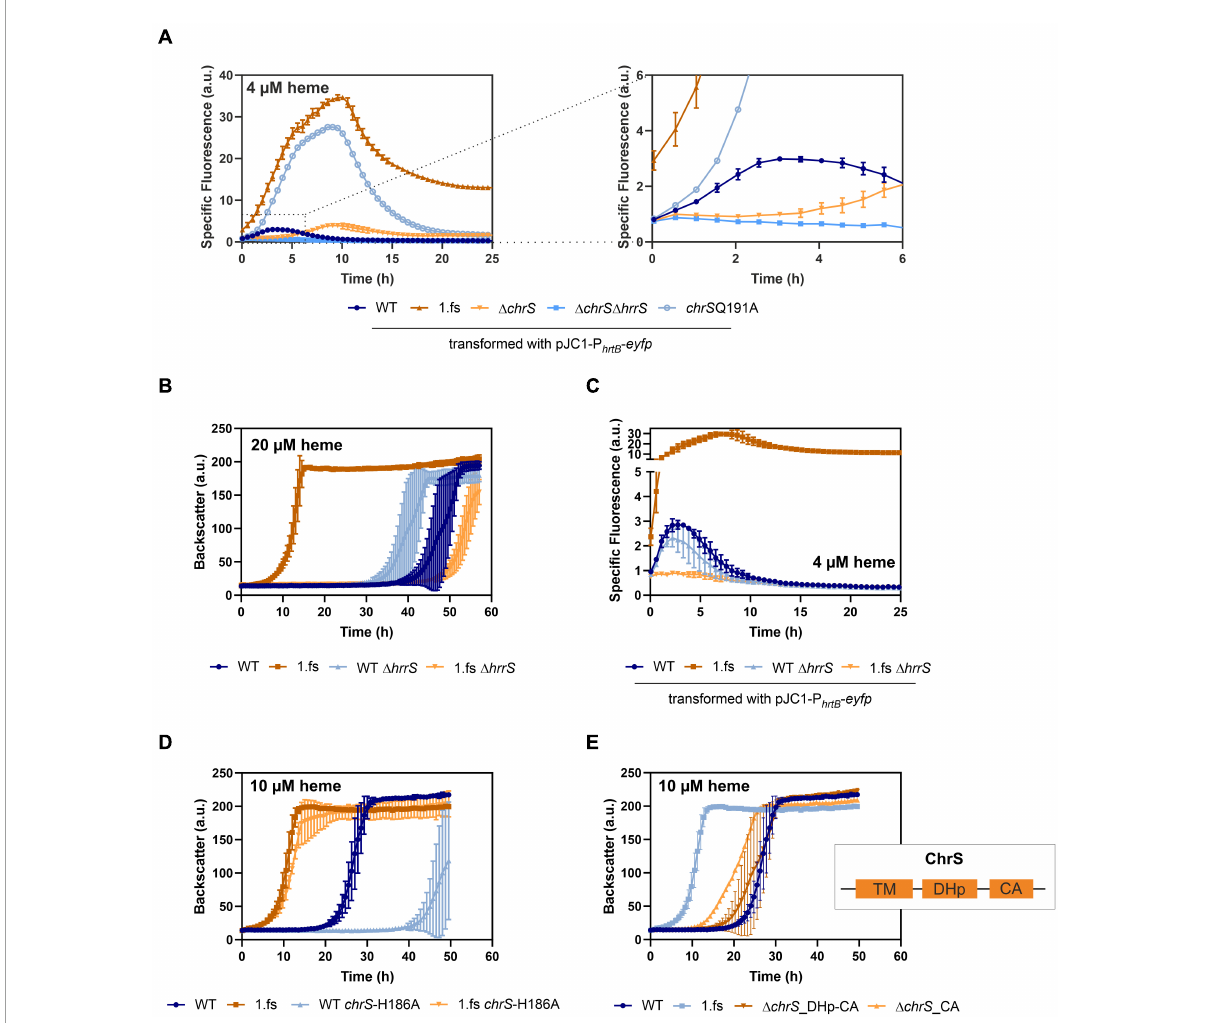
FIGURE4 Mutational analysis provides insights in the hrtBA activating cascade of the evolved C. glutamicum 1.fs clone. Data represent the average of three biological replicates including standard deviations depicted as error bars. Cells were inoculated at a starting-OD 600 of 1 in CGXII medium containing 2% glucose and the indicated amount of heme or iron. (A) Reporter assays visualizing hrtBA -expression using the plasmid pJC1-P hrtB - eyfp for transformation of the wild type (WT) (dark blue), the evolved clone 1.fs (dark orange), (cid:49) chrS (light orange), (cid:49) chrS (cid:49) hrrS (mid-blue), and chrS -Q191A (light blue). (B) Growth of the evolved clone (shades of orange) and the WT (shades of blue) natively or with each a deletion of hrrS . (C) Reporter assays for hrtB -expression using pJC1-P hrtB - eyfp upon deletion of hrrS in 1.fs (shades of orange) and the WT (shades of blue). (D) Growth of the wild type strain (shades of blue) and the evolved 1.fs strain (shades of orange) natively or possessing an amino acid exchange of the autophosphorylation histidine (H 186 ) of ChrS. (E) Impact of ChrS truncation on growth; ChrS variants lacking only the CA-domain (light orange) or CA-domain and DHp-domain (dark orange) compared to the WT and 1.fs strain (shades of blue). TM, transmembrane domain; DHp, dimerization- and histidine-phosphotransfer-domain; CA, catalytic- and